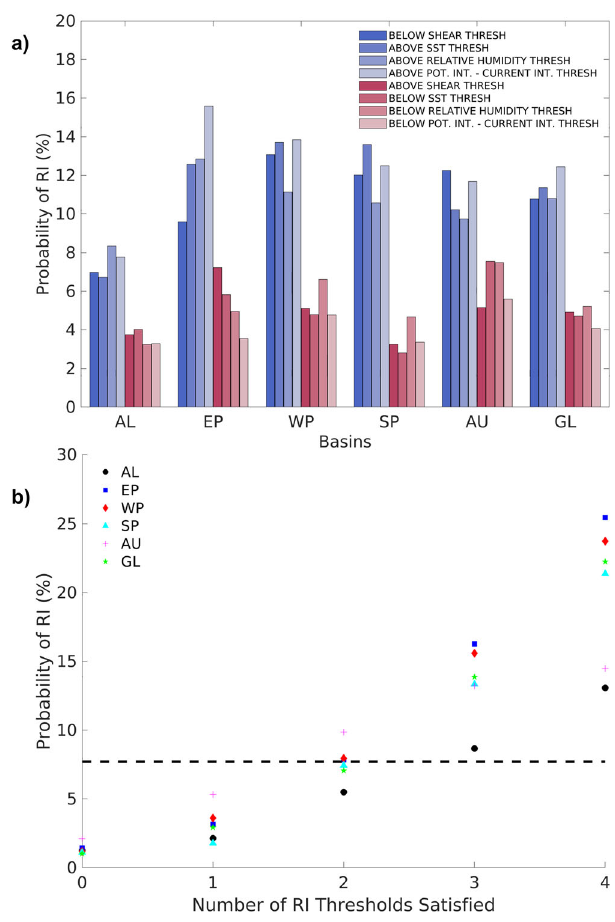
Fig. 3 | Storm environment and rapid intensi fi cation probability. a Histograms forsixbasins(Atlantic[AL],EastPaci fi c[EP],WestPaci fi c[WP],SouthPaci fi c[SP], Australian [AU], and Global [GL]) and four ERA5 environmental variables (Shear, Relative Humidity, Sea Surface Temperature, Potential Intensity-Current Inten- sity) showing the probability of rapid intensi fi cation (RI) for cases satisfying the critical environmental thresholds (bluehistograms)and the probabilityofRI for cases where the critical thresholds are not met (red histograms). Critical thresholds are calculated by solving a logit equation for the environmental variable value that yields the average basin-wide probability of RI. b The prob- ability of RI for six basins dependent on the number of critical thresholds (as de fi ned in text) met. The black dashed line indicates the global probability of RI for all